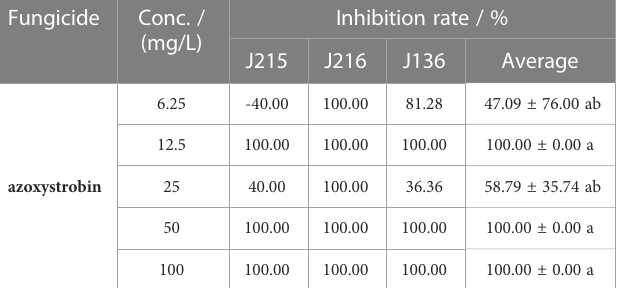
TABLE 2 In vitro inhibition of azoxystrobin against sclerotial formation by Rhizoctonia solani isolates J215, J216 and J36 from tobacco. Fungicide